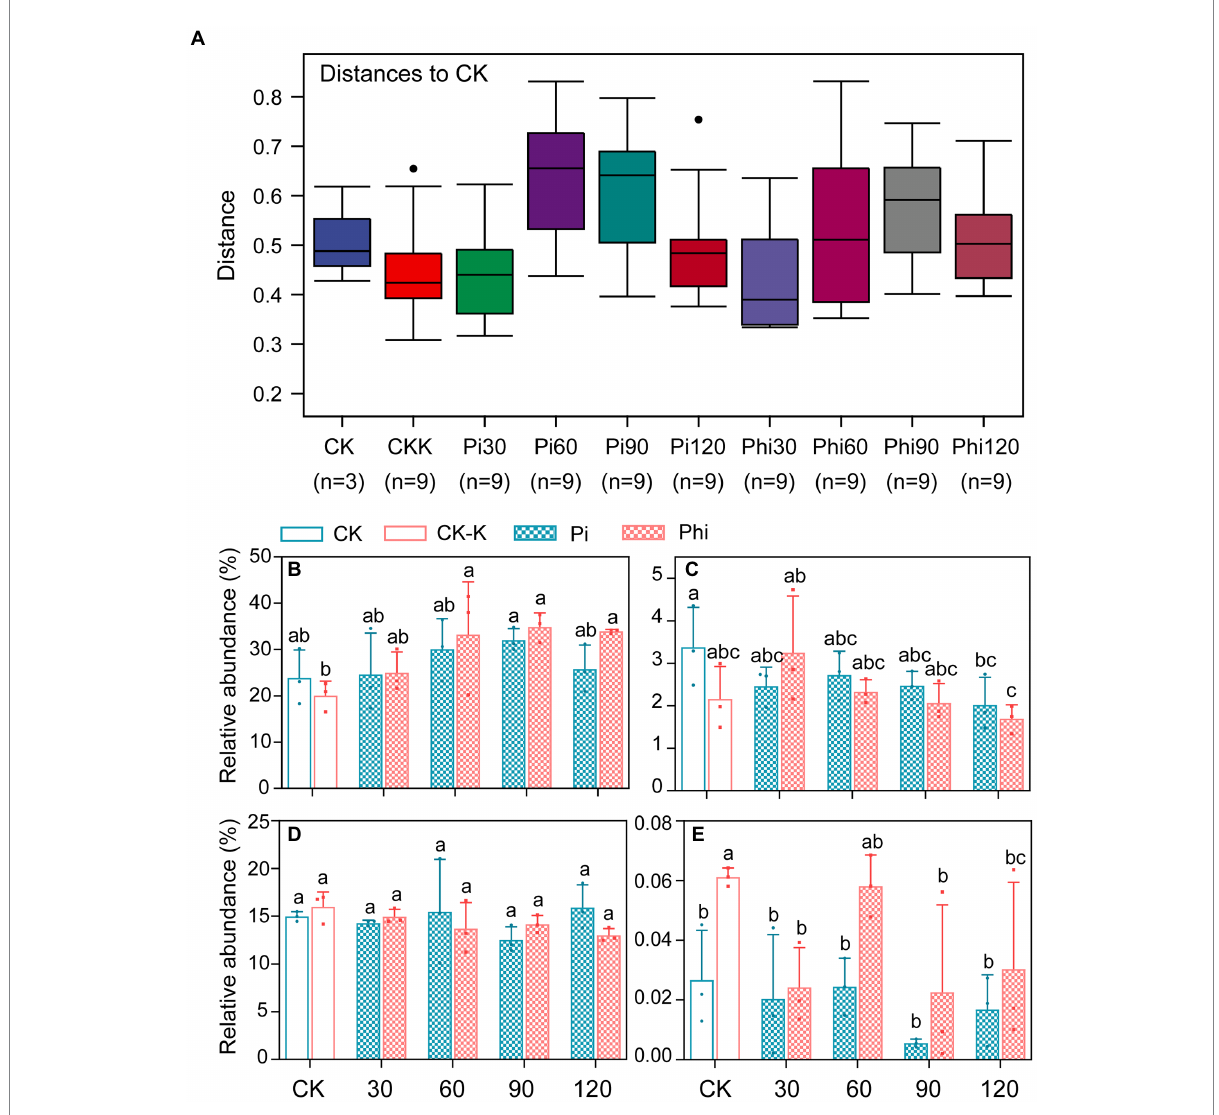
FIGURE 4 The differences between treated groups and control group (A) and the relative abundance of phyla contained Proteobacteria (B) , Firmicutes (C) , Actinobacteria (D), and Acidobacteria (E) under phosphate and phosphite fertilizers. (A) The box represents the distance between samples internal group and the distance between control sample and other groups. The point outside the upper and lower edges represents an abnormal value. Phi, phosphite fertilizer; Pi represents phosphate fertilizer. The values 30, 60, 90, and 120 mg P 2 O 5 kg − 1 soil indicate the fertilizer concentration used in the study. The levels of columns are represented as the average value ± standard error ( n = 3), and the different letters indicate the significant differences ( p <